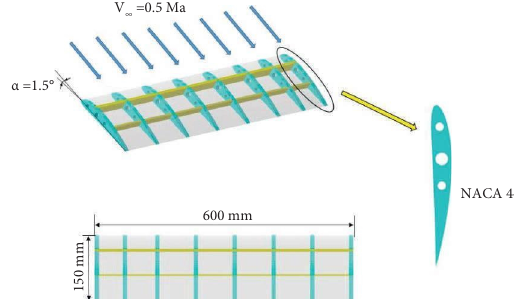
Figure 3: Wing structural dimensions and incoming fow conditions.